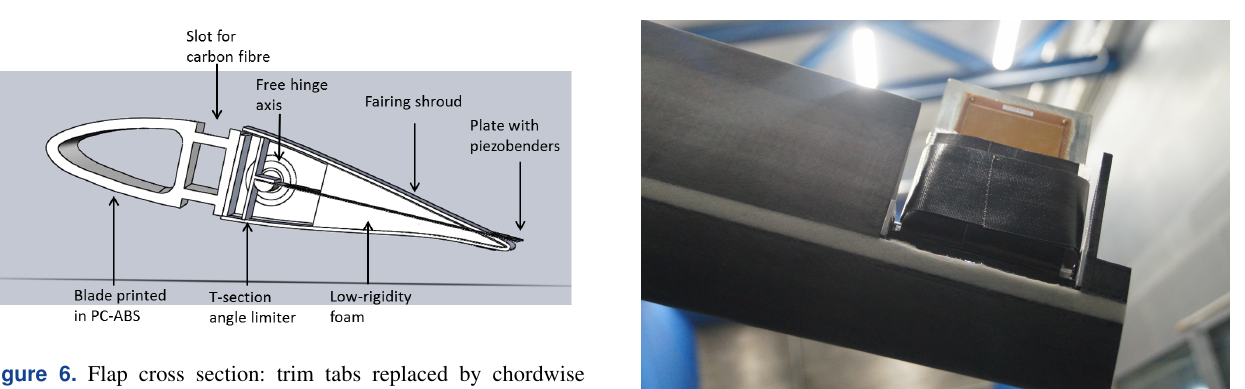
Figure 6. Flap cross section: trim tabs replaced by chordwise piezobenders.